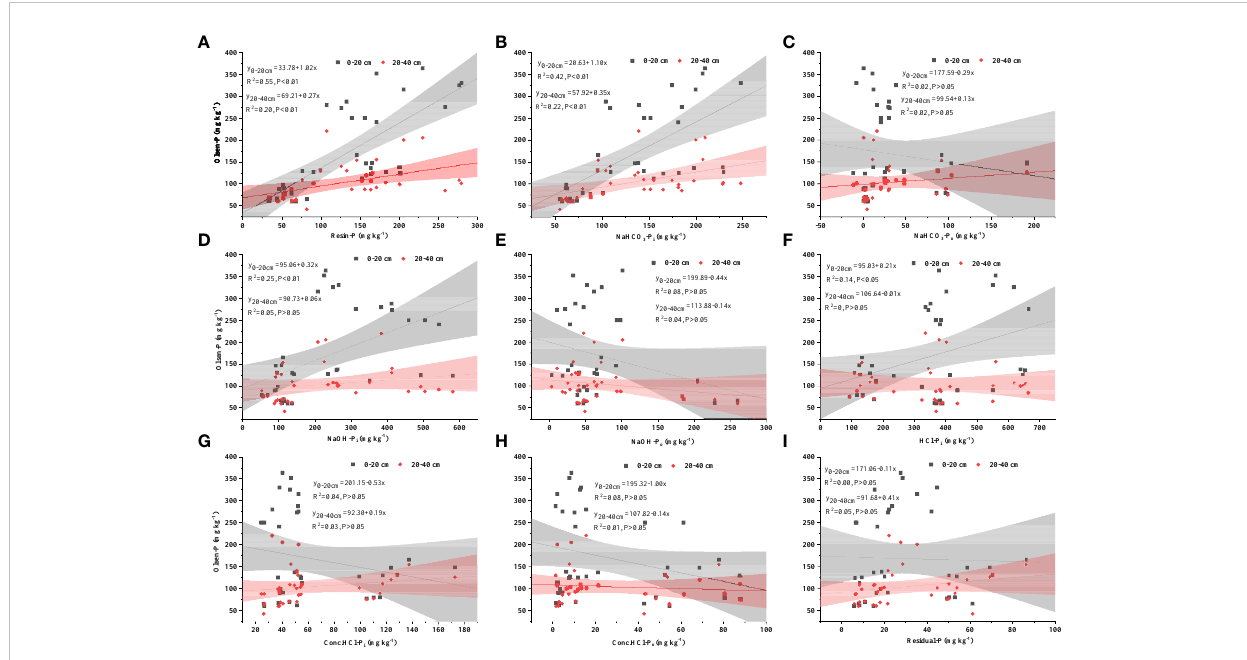
FIGURE 5 Relationships between available P (Olsen-P) concentration and soil labile-P: Resin-P (A) , NaHCO 3 -P i (B) , NaHCO 3 -P o (C) ; Moderately Labile-P: NaOH-P i (D) , NaOH-P o (E) , HCl-P i (F) and Sparingly Labile-P: Conc.HCl-P i (G) , Conc.HCl-P o (H) and Residual-P (I) , at 0-20 cm, 20-40 cm soil depth, per layer for all 36 samples of 3 treatments in the current study. P indicates signi fi cant regressions at< 0.01 , < 0.05 or > 0.05 levels,